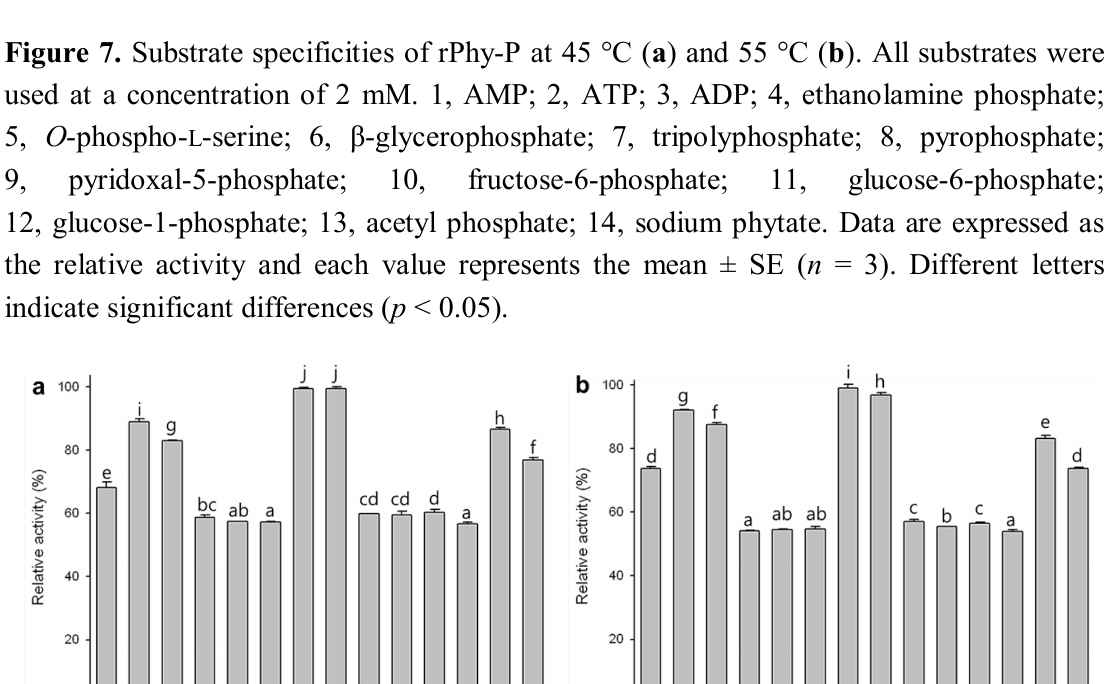
Figure 7. Substrate specificities of rPhy-P at 45 °C ( a ) and 55 °C ( b ). All substrates were used at a concentration of 2 mM. 1, AMP; 2, ATP; 3, ADP; 4, ethanolamine phosphate;